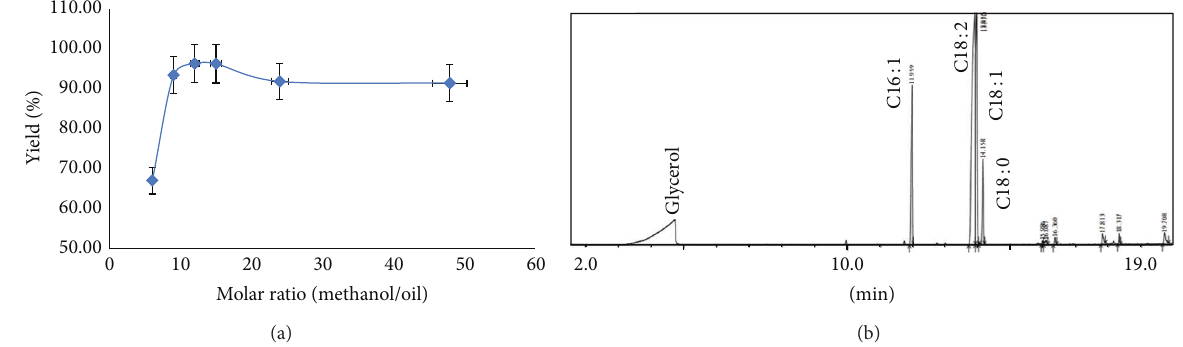
Figure 2: (a) Effect of methanol to oil molar ratio on percentage biodiesel yield. (b) GC-MS of biodiesel produced using 24 :1 methanol : oil molar ratio.